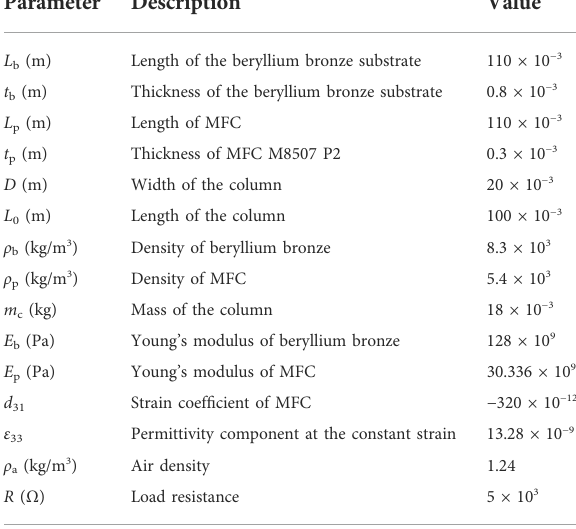
TABLE 1 Physical parameters and geometric dimensions of the variable cross-section energy harvester. Parameter